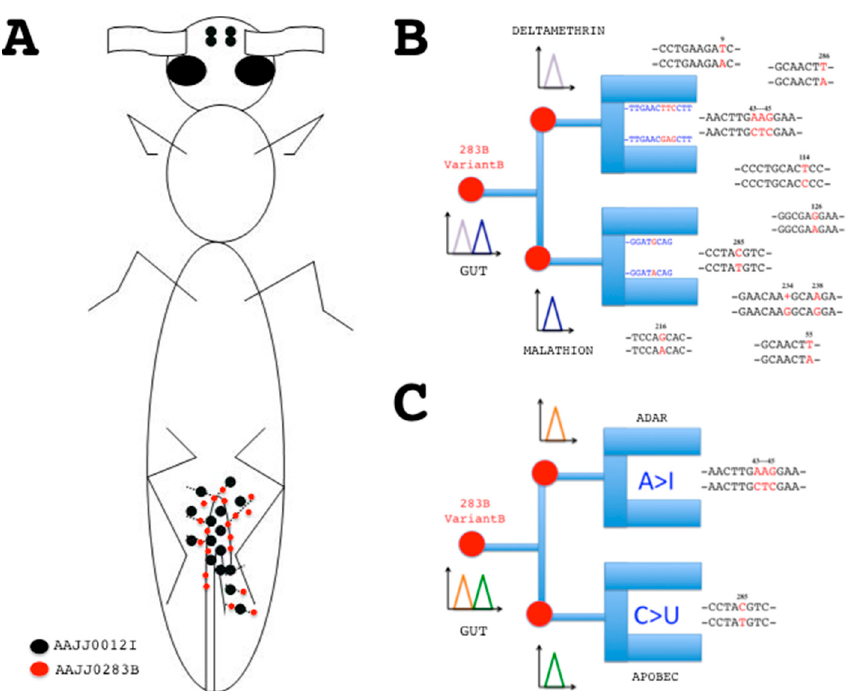
Figure 3. Principle of sensor chips based on CSP-RNA mutations. ( A ) Distribution of EST-cDNA sequences (red/black dots) encoding CSPs in young adults of T. castaneum (flybase.org). Hindgut and Malpighian tubules: DT776391, DT782506, DT783721, DT785607, ES548720, ES548948, ES549909, ES549995, ES550112, ES550327, ES550345, ES550411, ES550426, ES550567 ( AAJJ0012I ); DT773281, ES548660, ES548870, ES549463, ES549545 ( AAJJ0283B ). Head: ES544614, ES544679 ( AAJJ0012I ) [56,57];